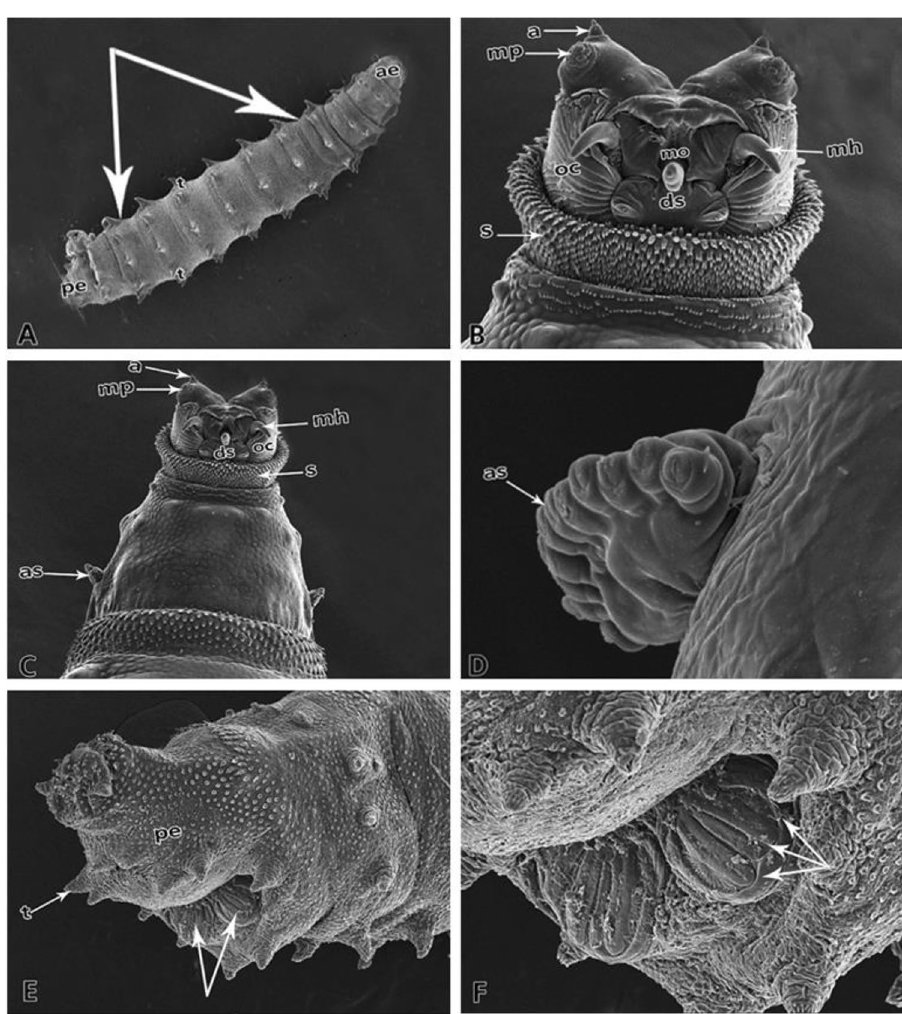
Figure 3. Scanning electron micrographs of a third instar larva of Chrysomya albiceps . ( A ) Larval body composed of groups of tubercles (t) located at the anterior and posterior ends of each segment, anterior (ae), and posterior ends (pe), abdominal segments (arrows). ( B ) Cephalic region with antennae (a), maxillary palp (mp), spines (s), dental sclerite (ds), mouth hooks (mh), oral cristae (oc), and anterior spiracle (as). ( C ) Details of antennae (a) and maxillary palp with five papillae and anterior spiracle (as), spines (s), oral cristae (oc), and dental sclerite (ds). ( D ) Details of anterior spiracles (as) in a row. ( E ) Anal segment with posterior spiracles (arrows). ( F ) Details of anal segment with three spiracular openings